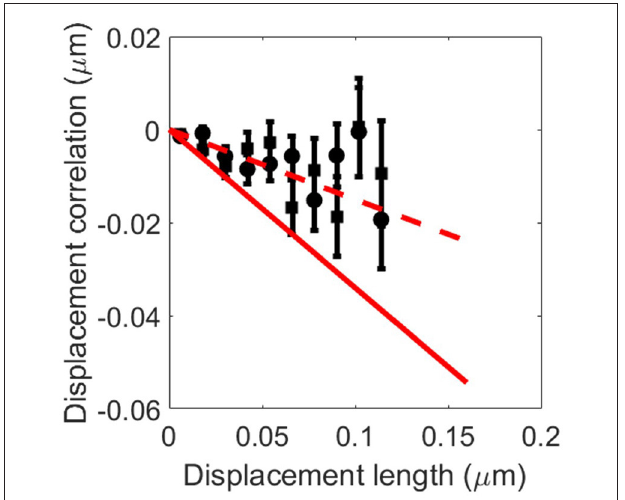
FIGURE 4 | Quantitative analysis of particle tracking. The dependence of the displacement correlation as defined in the main text, as function of the displacement length for yeast ( S. cerevisiae ) treated with 0.8M sorbitol (circles) and 1M sorbitol (squares). The solid line correspond to the dependence of the correlation on displacement length for acidified cells, and the dashed line corresponds to healthy, log-phase cells from Munder et al. [ 14]. The displacement correlation measured in osmotically stressed cells is consistent with healthy cells, but not with acidified